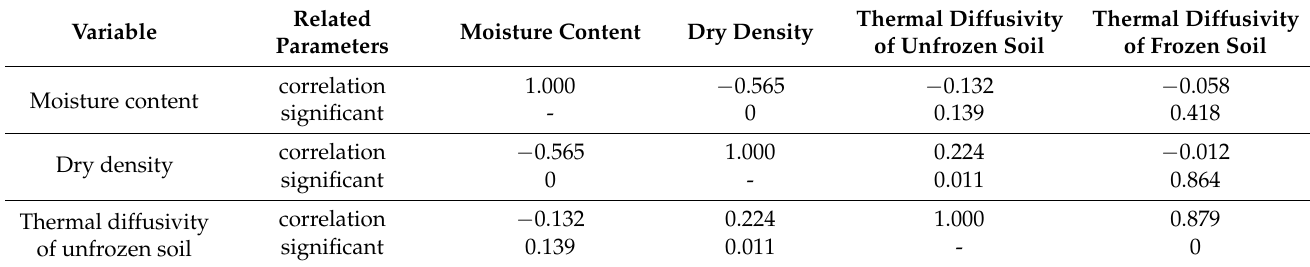
Table 3. Partial correlation analysis results of thermal diffusivity and influencing factors.